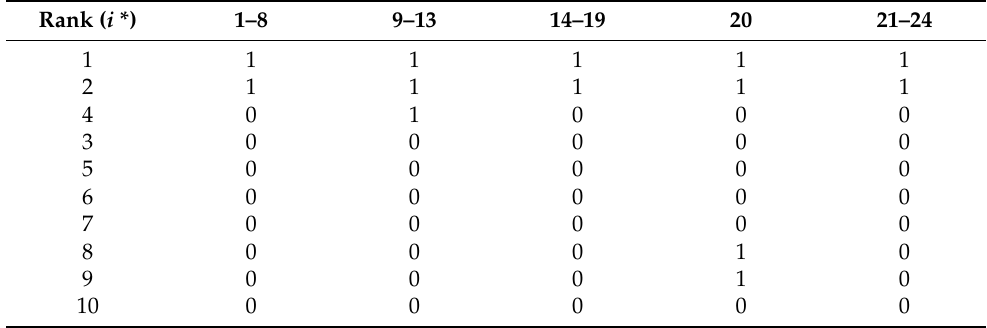
Table 5. Global optimum UC of the proposed BM solution (* indicates the priority ordered units, while bold numbers show the must-run